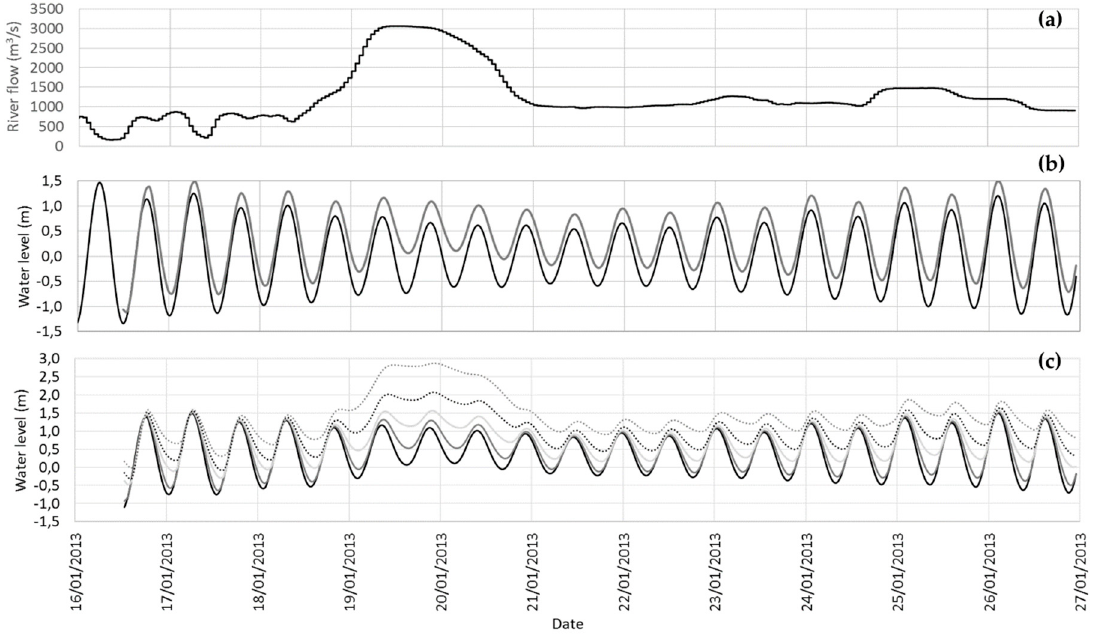
Figure 8. Scenario S3: boundary conditions and time series at the numerical tidal gauges. Time from 16 January 2013 00:00 h UTC. ( a ) River flow rate at the upstream boundary; ( b ) tidal level at the ocean boundary (—) and water level at the numerical gauge T1 ( — ); and ( c ) water level at the numerical